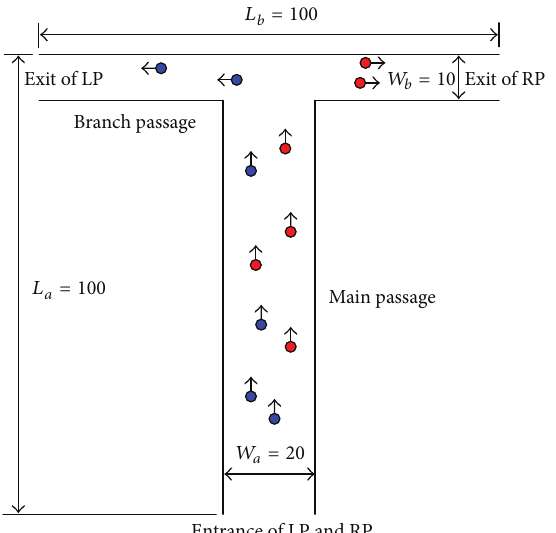
Figure 1: Simulation scenario of T-shaped